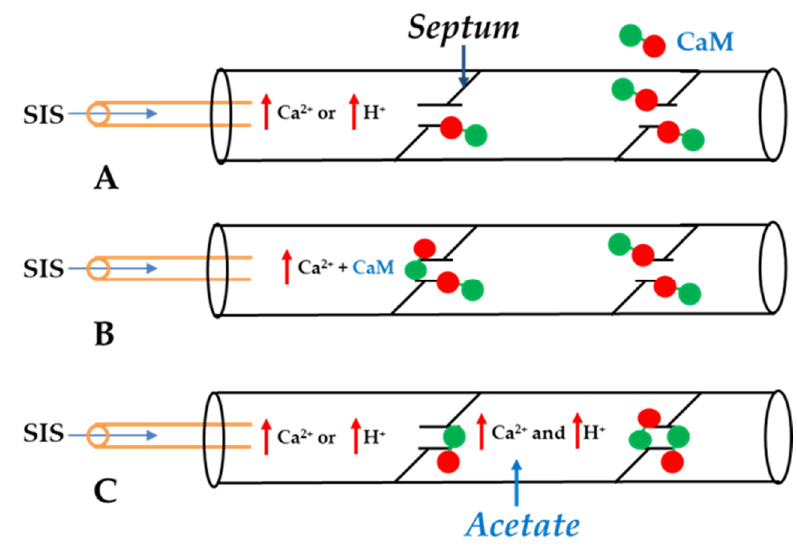
Figure 2. Summary of data from refs. [53,54,59]. While internal perfusion of crayfish lateral giant axons with Standard Internal Solution (SIS) with high [Ca 2+ ] and/or [H + ] does not induce channel gating ( A ), addition of 10 µM CaM to internal solutions with high [Ca 2+ ] does ( B ). Axons internally perfused with high [Ca 2+ ] and/or high [H + ] without CaM uncouple with extracellular perfusion of Standard Extracellular Solution (SES) containing 205 mM Na-acetate ( C ), as acetate increases [Ca 2+ ] i by increasing [H + ] i in the un-perfused axon segment. (Red circle: CaM’s C-lobe; Green circle: CaM’s N-lobe).